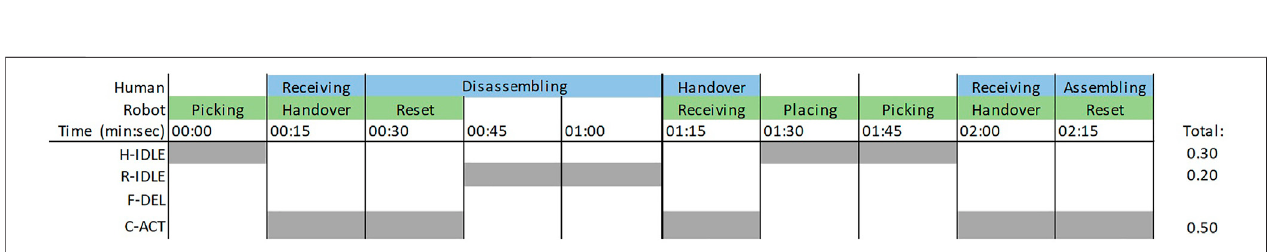
FIGURE 11 | Task assignment chart for the baseline approach of strict turn taking, where each action is immediately followed by the next action of the other teammate. The fl uency metrics indicate a relatively high human and robot idle time (H-IDL and R-IDL) and low concurrent activity (C-ACT). Functional delay (F-DEL) is avoided completely.